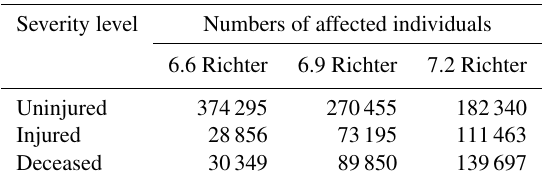
Table 2. Results of earthquake